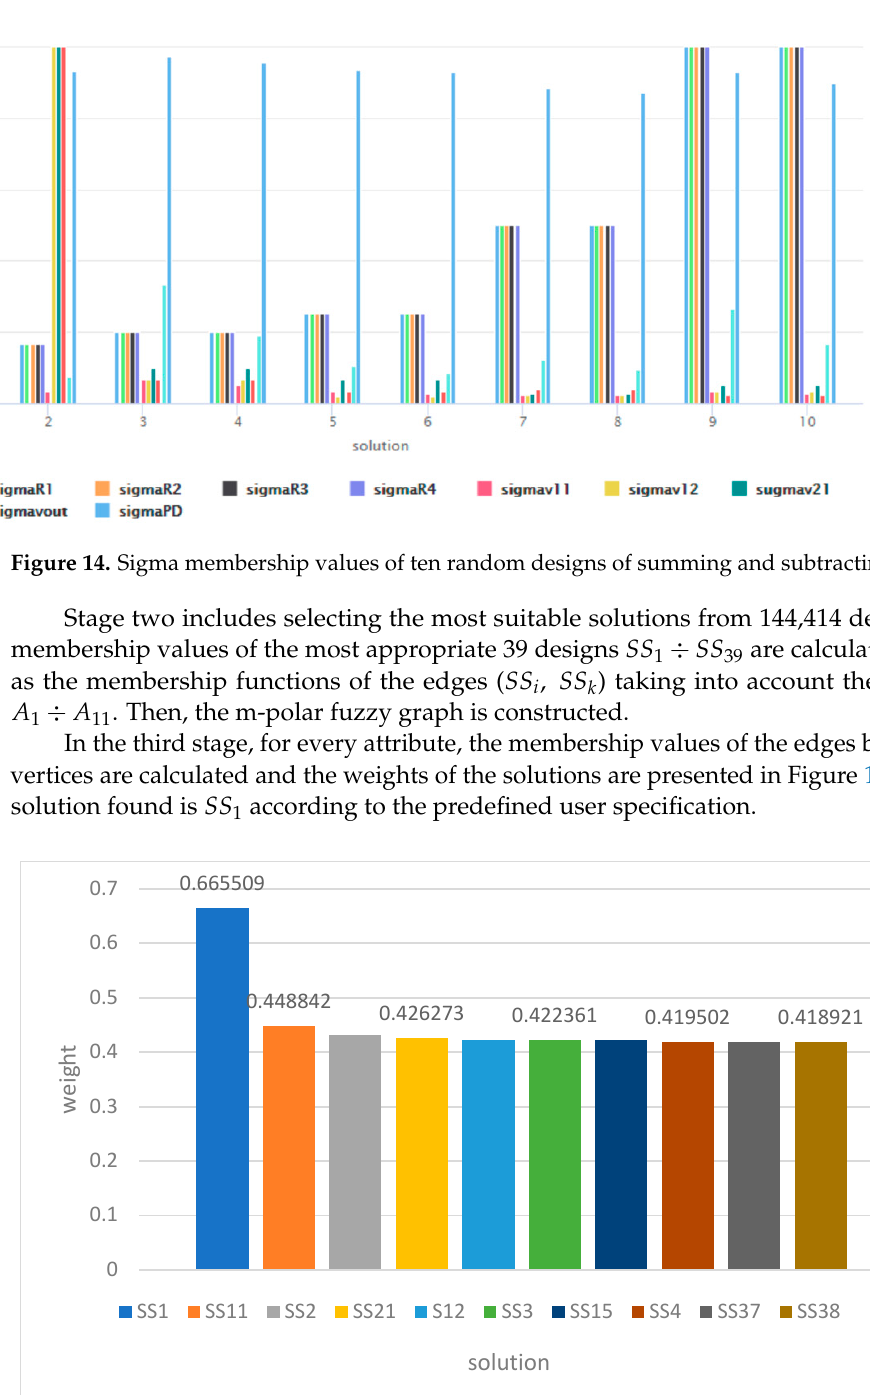
Figure 13. The prediction chart of the membership values of power dissipation (sigma) at design of summing and subtracting amplifier.